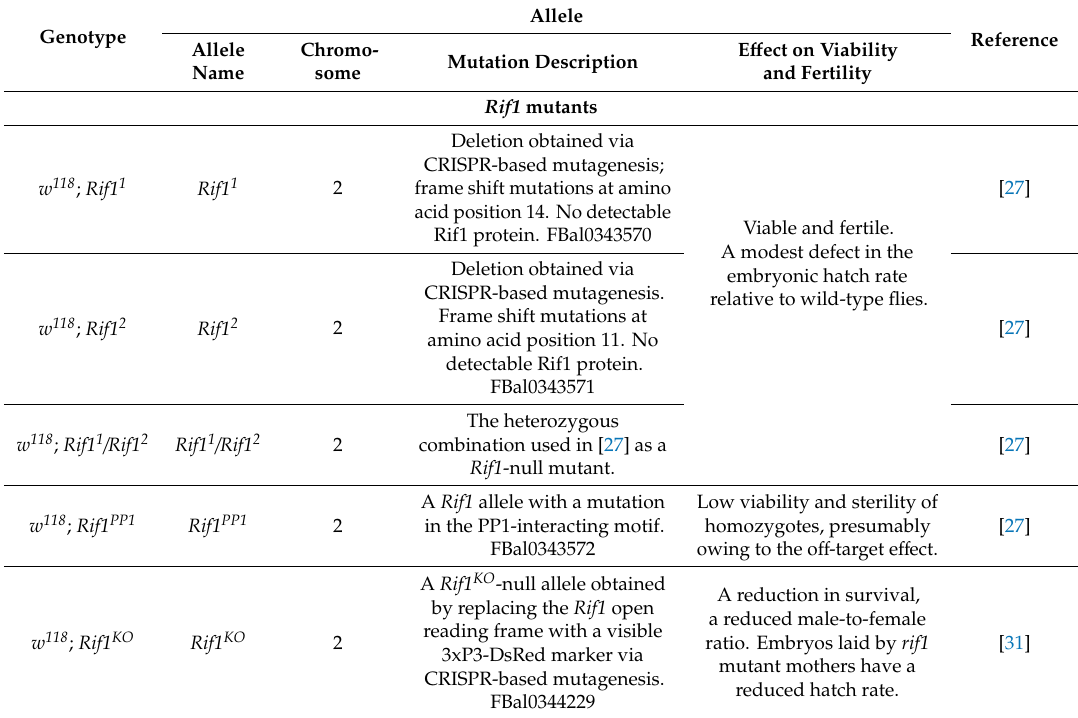
Table 1. Description of the mutations used in this